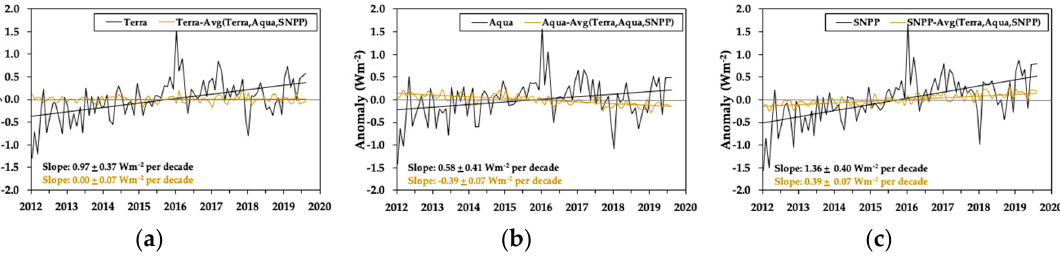
( c ) Figure 1. SW global all-sky flux anomalies for the period 02/2012–09/2019 using the SSF-1deg products for: ( a ) Terra using the Edition-4 data products; ( b ) Aqua using the Edition-4 data products; and ( c ) S-NPP using the Edition-1 data products. Additionally, shown is the difference between the individual instrument anomalies and the anomaly of the average of the three instruments. Uncertainties in slope correspond to 95% confidence intervals. All three CERES instruments show a large decrease in reflected SW radiation for the period considered. This trend is associated with short-term interannual variability rather than a long-term trend [8]. It is noted that differences in the trends amongst the three CERES instruments is at least a factor of seven smaller than the trend itself and remains < 0.18 Wm -2 per decade. Part of this small difference could be due to differences in diurnal sampling between Terra (10:30 am equator crossing time) and Aqua or SNPP (1:30 pm equator crossing time).